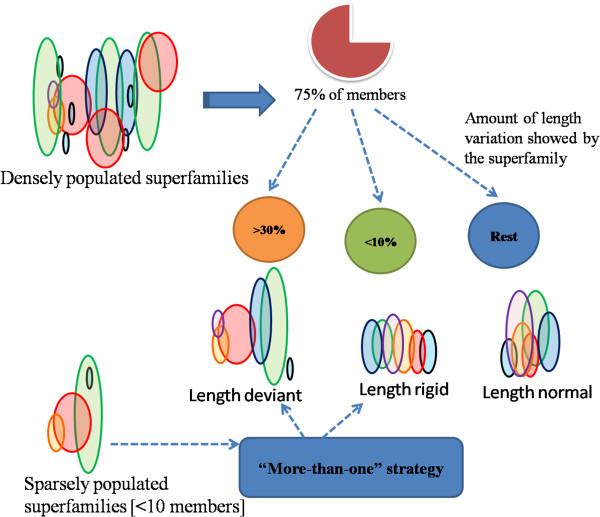
Flowchart of the classification approach used to divide all the multi-membered superfamilies into groups based on their nature of length variations.